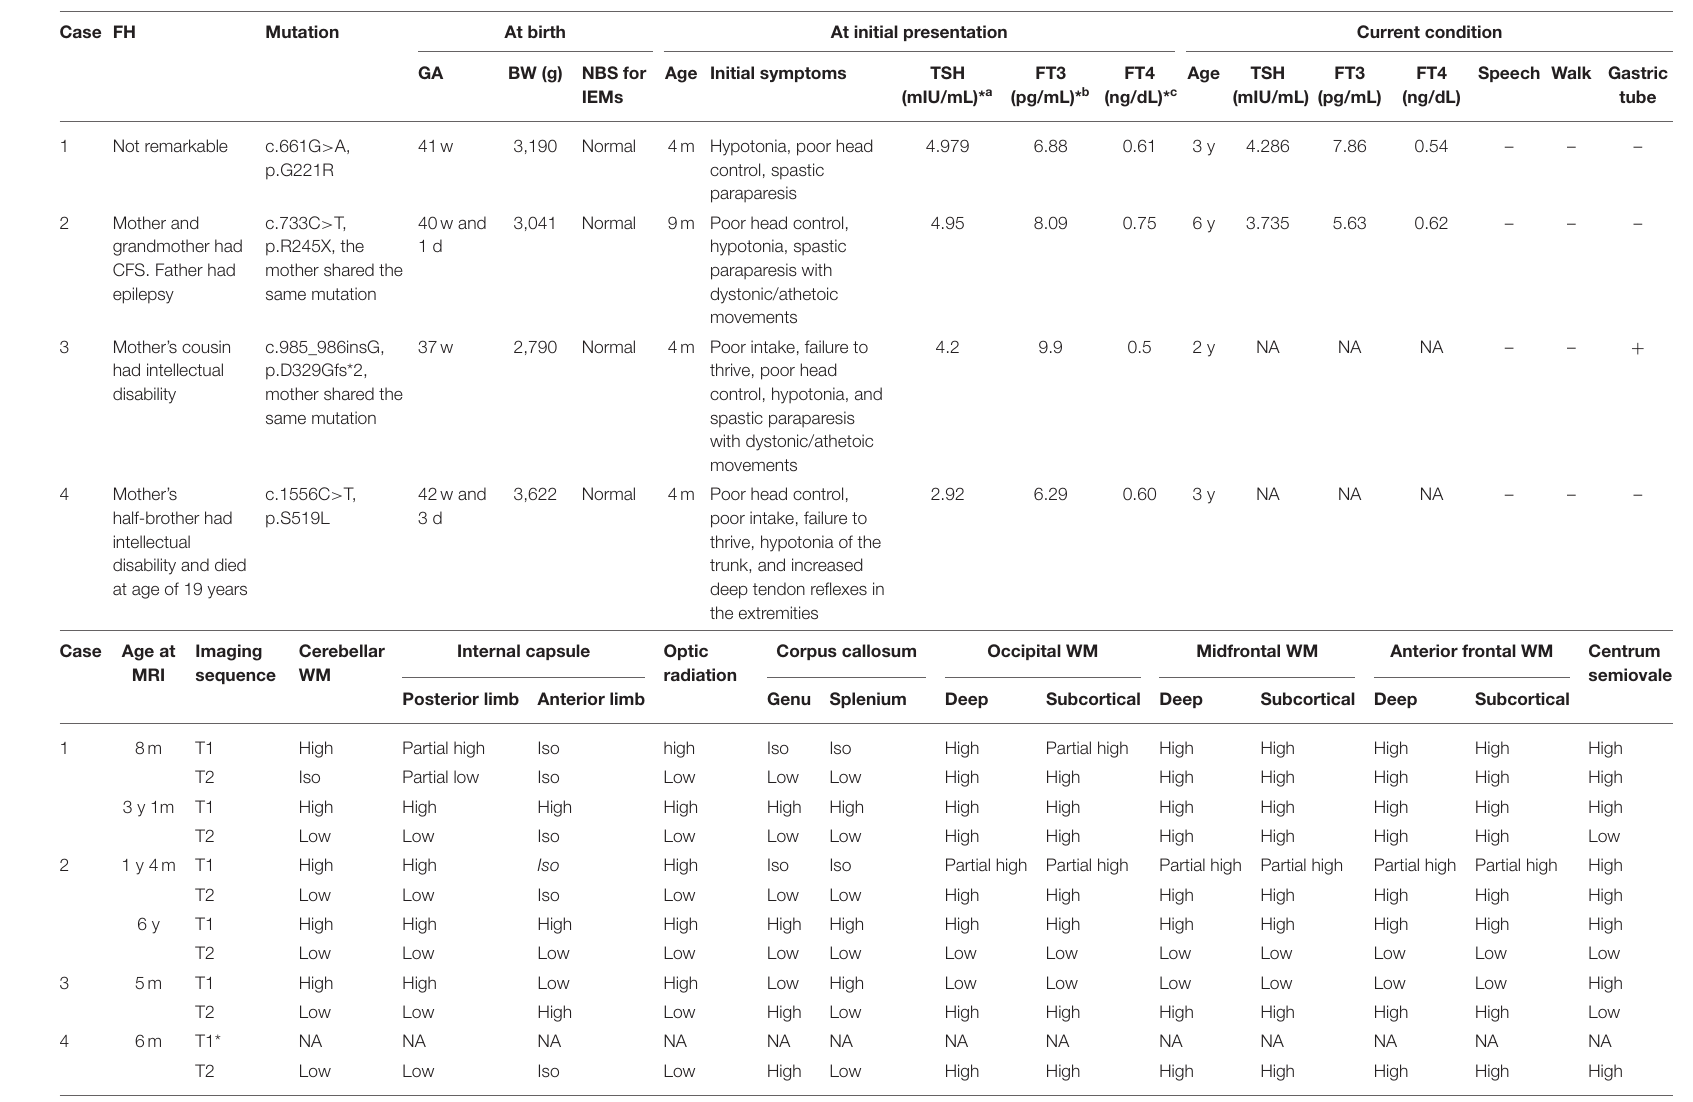
TABLE 1 | Summary of the clinical course, thyroid function tests, and myelination status in brain T1- and T2-weighted MRI images of the four patients with MCT8